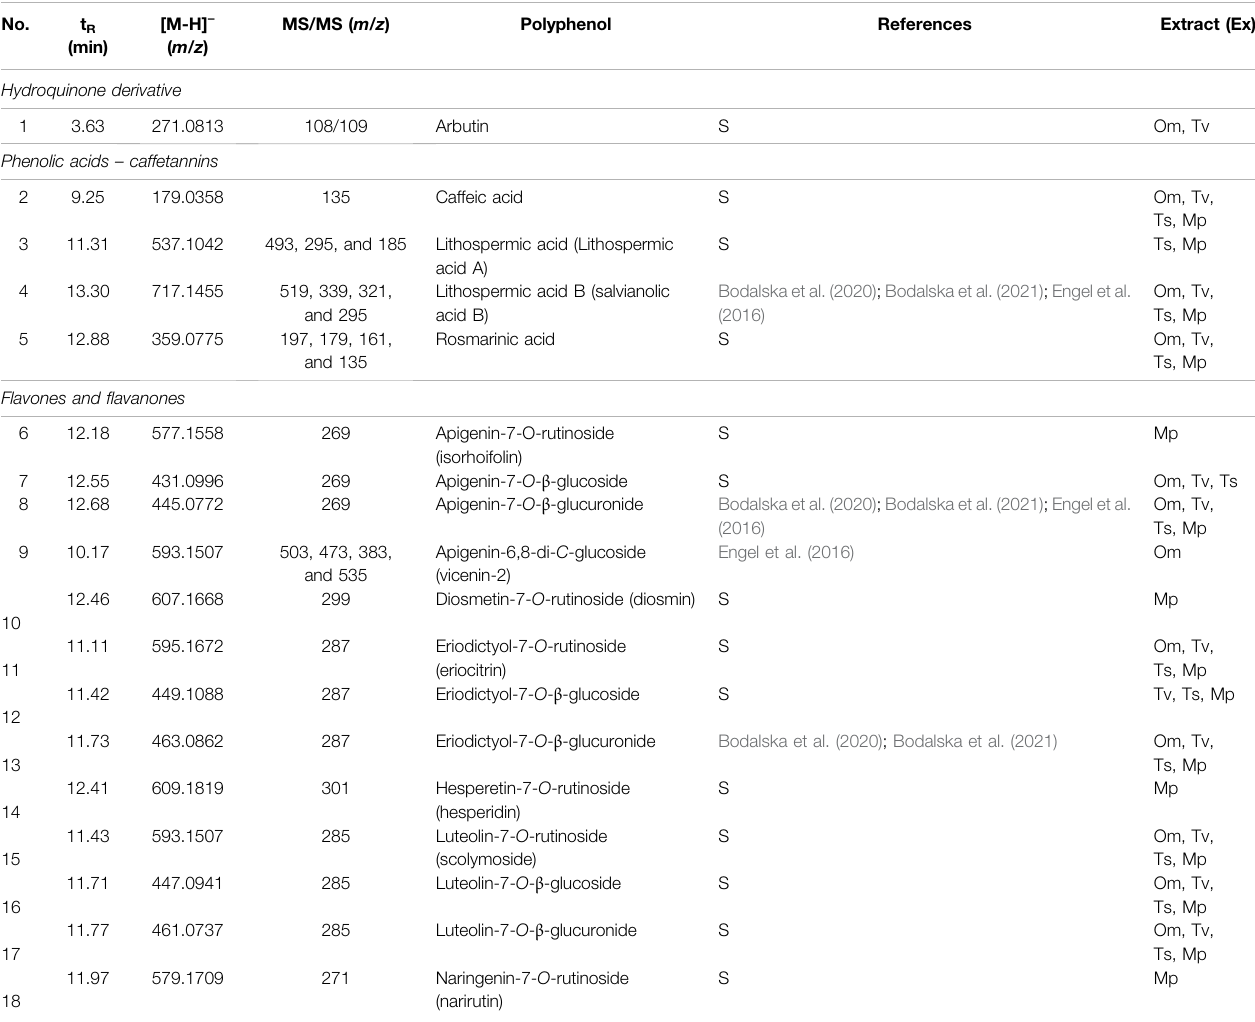
TABLE 1 | UHPLC-MS identi fi cation of Lamiaceae polyphenols.